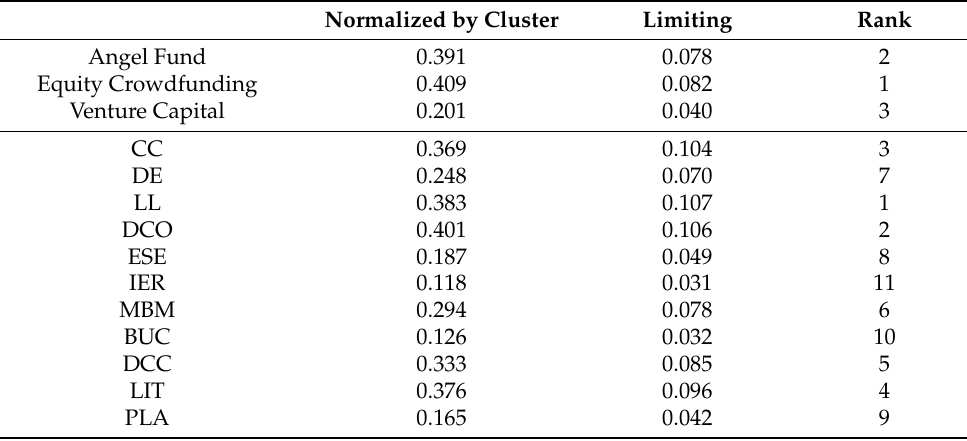
Table 4. The priorities of criteria and